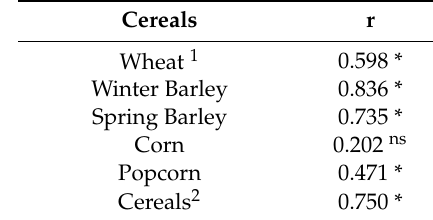
Table 6. Pearson’s correlation coefficients ( r ) between total phenolic content (TPC) and DPPH scavenging activity.